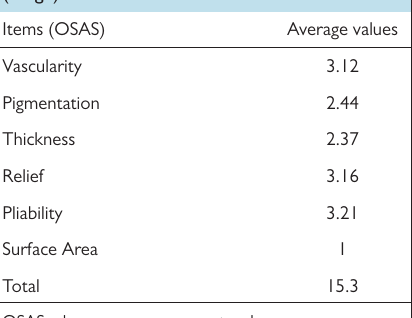
Table 2. Total Observer Scar Assesment Scale (OSAS) Scores. Values are presented as average